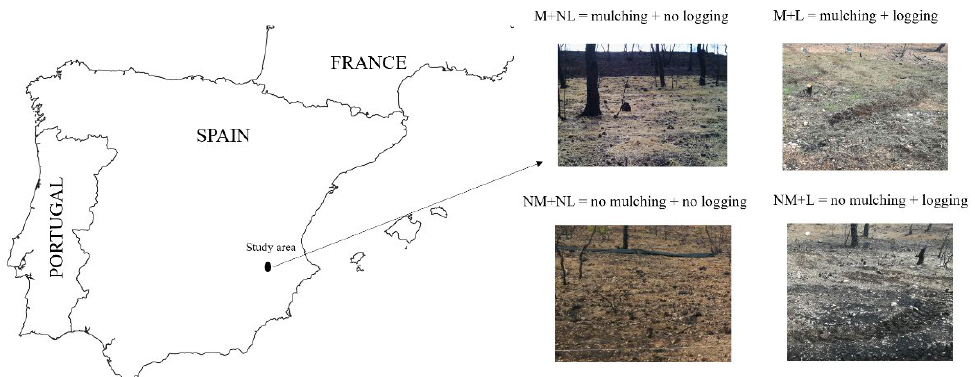
Figure 1. Geographical location of the study area (Sierra de las Quebradas forest, Castilla-La Mancha, Central-Eastern Spain.